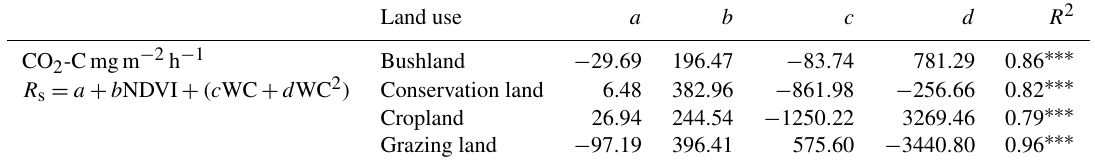
Table 4. Combined effects of soil water content (WC) and the NDVI on soil CO 2 emissions. Soil CO 2 emissions denoted by R s , while a , b , c , and d are the model coefficients and ( R 2 ) is the coefficient of